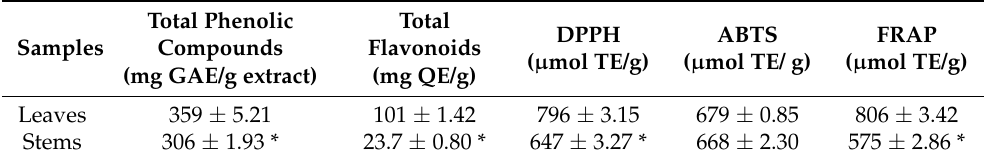
Table 4. Total phenolic compounds, total flavonoids and antioxidant activity of leaves and stems of J. macrantha ethyl acetate fraction.